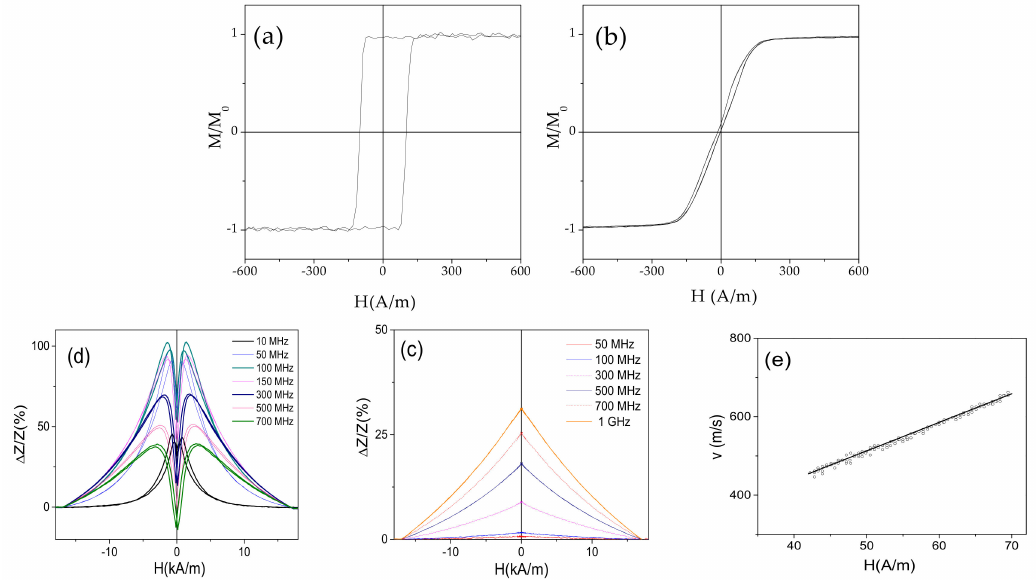
Figure 2. Hysteresis loops of magnetic microwires Fe 75 B 9 Si 12 C 4 with positive ( a ) and Fe 3.6 Co 69.2 Ni 1 B 12.5 Si 11 Mo 1.5 C 1.2 with nearly-zero ( b ) λ s values, ∆ Z / Z ( H ) dependencies of as-prepared Fe 75 B 9 Si 12 C 4 ( c ) and Fe 3.6 Co 69.2 Ni 1 B 12.5 Si 11 Mo 1.5 C 1.2 ( d ) microwires and v (H) dependence